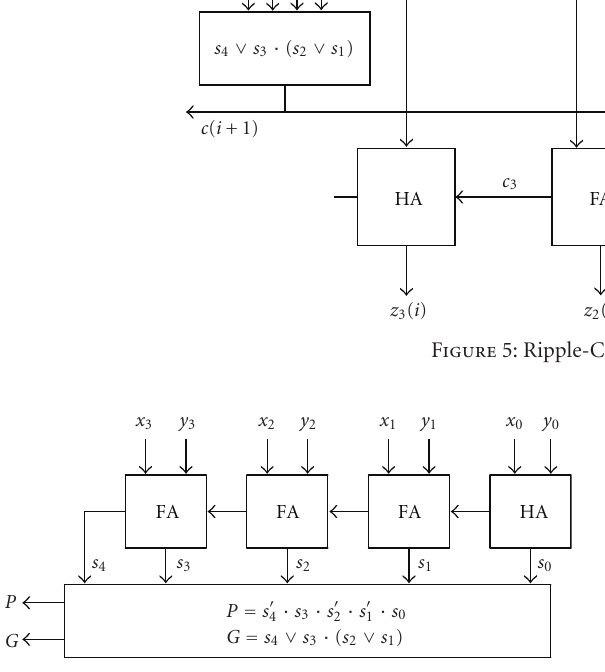
Figure 6: G-P cell for BCD adder.